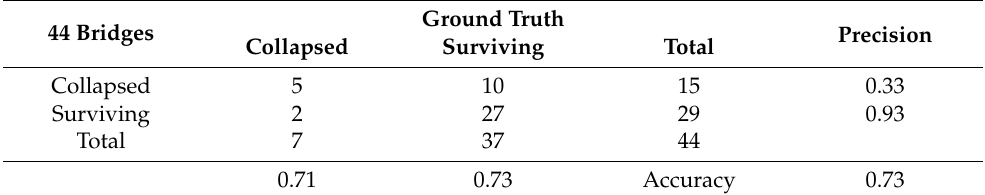
Table 7. Confusion matrix of the validation set using the LR model with three input